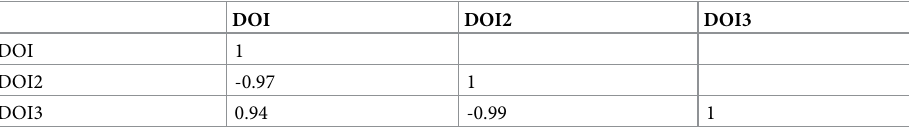
Table 3. Internationalization degree high power correlation coefficient